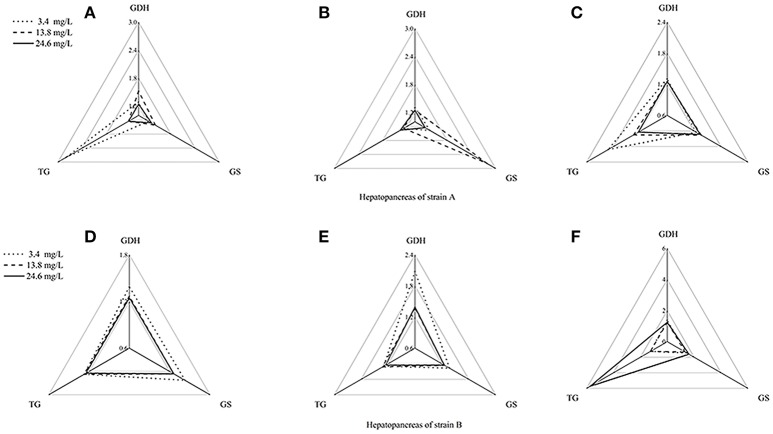
Star plots for biomarker responses in hepatopancreas of strain A exposed to different ammonia-N concentrations. The relative area of triangles (clockwise direction) indicated that the affected degree of ammonia-N to GDHase, TGase and GSase, respectively. (A) Star plots for biomarkers response in hepatopancreas of strain A under ammonia-N pollution stress for the first day. (B) Star plots for biomarkers response in hepatopancreas of strain A under ammonia-N pollution stress for the fifth day. (C) Star plots for biomarkers response in hepatopancreas of strain A under ammonia-N pollution stress for the tenth day. (D) Star plots for biomarkers response in muscle of strain A under ammonia-N pollution stress for the first day. (E) Star plots for biomarkers response in muscle of strain A under ammonia-N pollution stress for the fifth day. (F) Star plots for biomarkers response in muscle of strain A under ammonia-N pollution stress for the tenth day.